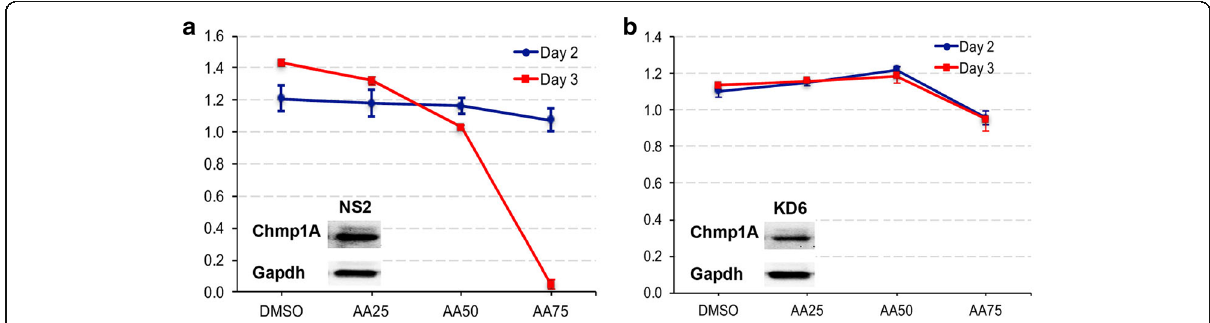
Fig. 5 Chmp1A is required for the cytotoxic effect of AA. Panels show control shRNA (NS2, ( a ) and Chmp1A specific shRNA (KD6, ( b ) expressing PANC-1 cells. Control cells showed significant growth inhibition with AA treatment on day 3, compared to control DMSO ( a ). However, Chmp1A silenced cells showed slight growth promotion with AA treatment at 25 and 50 nM, but growth inhibition at 75 nM on both days ( b ), minor though compare to that at 75 nM in control on day 3 especially (red line in a ). Insets showed the validation of decreased Chmp1A protein in Chmp1A silenced KD6 cells ( b ), compared to control silenced NS2 cells ( a ). Blots for NS2 and KD6 are from the same Western blot. MTT data was acquired from three samples at 48 and 72 h after initial treatment. Error bars represent standard deviation